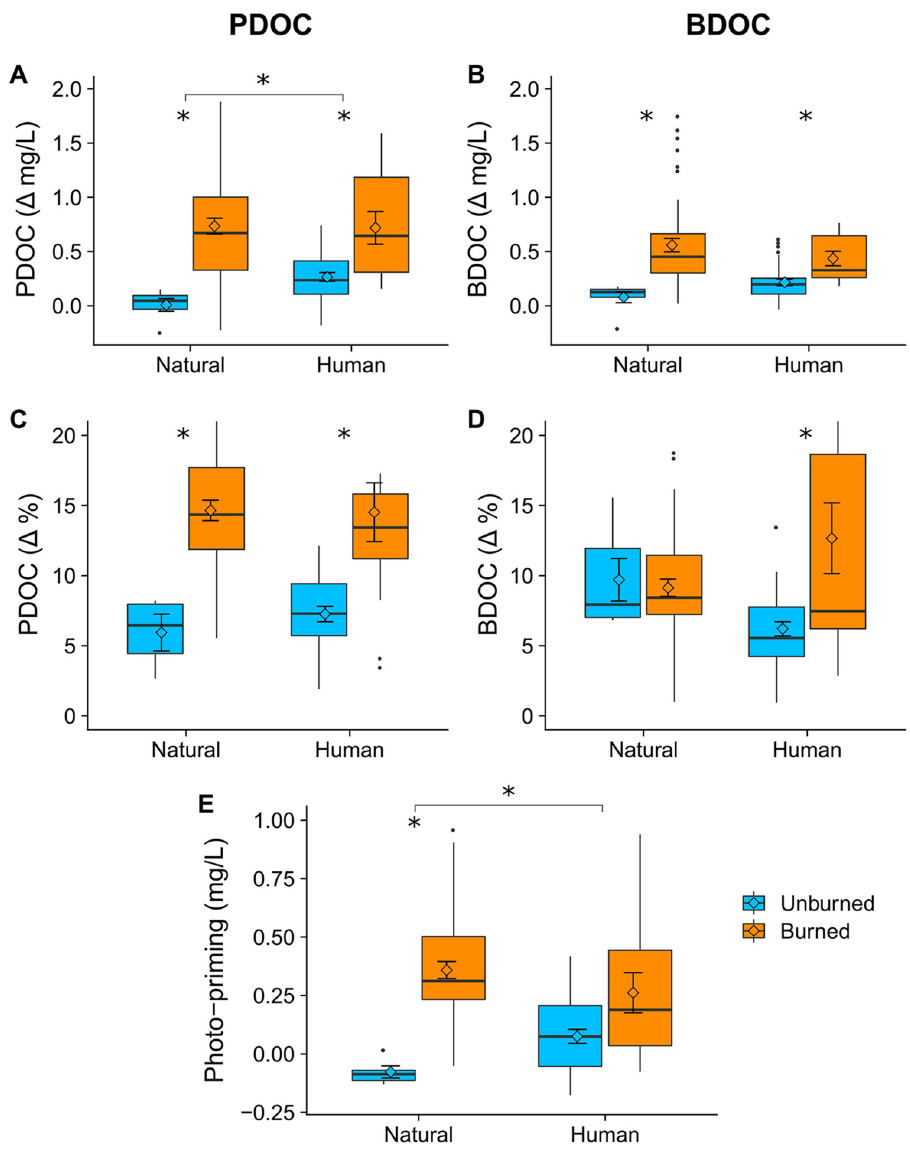
is the concentration and percent change for samples incubated under broad-spectrum radiation (see Methods) while biodegradable DOC (BDOC) is from the dark incubation. Panels A and B show the concentration of DOC (mg/L) that was lost during the incubation experiment. Panels C and D show the percentage of DOC lost during the experiment. Panel E shows the pairwise differences between A and B, representing the additional amount of DOC consumed due to exposure to light (i.e.